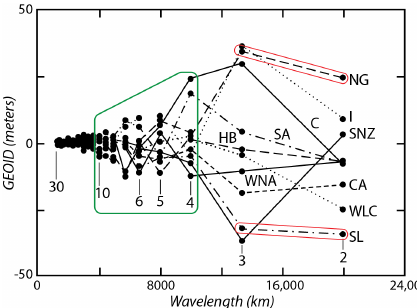
Figure 3. Magnitudes of individual harmonic degree contributions for the Earth’s 10 major geoid anomaly values computed from the GEM-9 coefficients referenced with reciprocal flattening of 298.257 (actual Earth flattening). Four positive anomalies are New Guinea (NG), Iceland (I), Crozet (C), and South America (SA). Six neg- ative anomalies are Indian Ocean (Sri Lanka) (SL), west of lower California (WLC), central Asia (CA), and south of New Zealand (SNZ). Reprinted from Bowin (1985) with